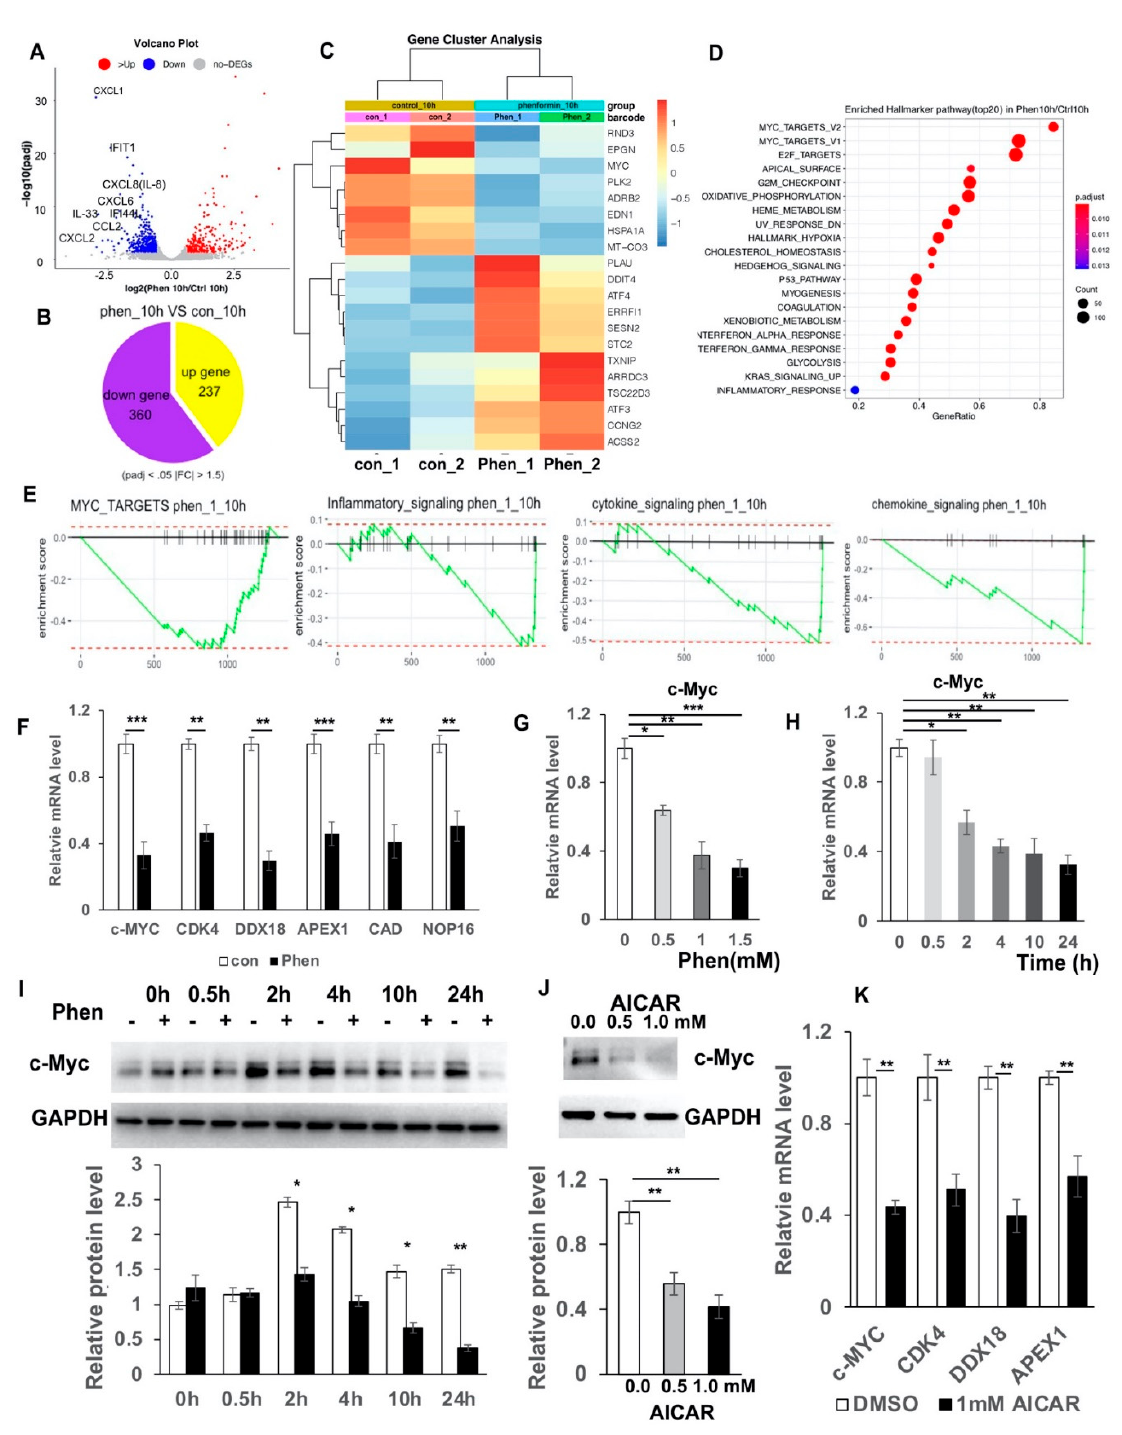
Figure 4. RNA-seq analysis reveals that phenformin suppresses c-Myc expression in human ker- atinocytes. ( A ) Volcano plot visualizing DEGs between phenformin (1 mM)-treated cells (phen- formin_10h) and the control PBS-treated cells at 10 h (control_10h); a p value < 0.001 was used as a threshold to determine the significance of DEGs. Red dots represent up-regulated DEGs, blue